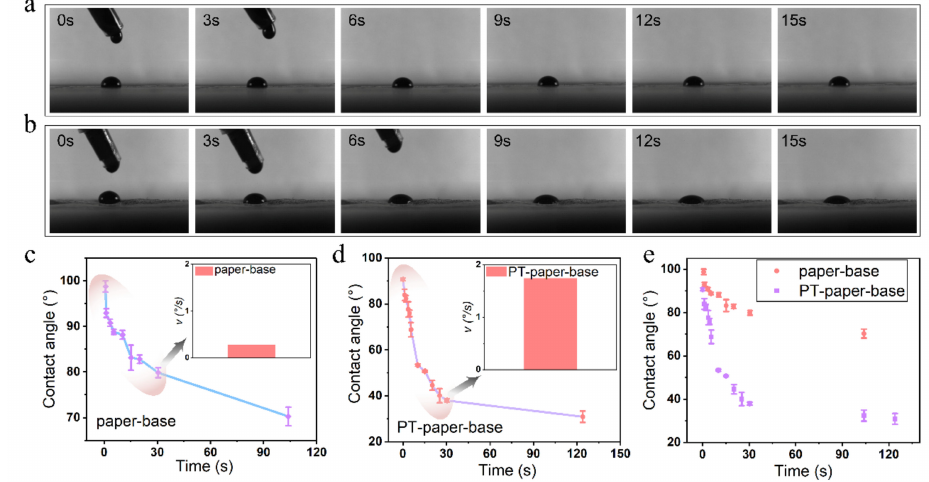
Figure 11. Infiltration of the tobacco extract on different tobacco paper-base surface. High-speed camera images of tobacco extract absorption on the ( a ) tobacco paper-base and ( b ) PT-tobacco paper-base surface; The infiltration contact angle of tobacco extract on the ( c ) tobacco paper- base and ( d ) PT-tobacco paper-base surface vs. time; ( e ) The infiltration contact angle compari- son of the tobacco extract on the tobacco paper-base and PT-tobacco paper-base surface. Inset: the mean infiltration rates of the tobacco extract on the ( c ) reconstituted tobacco paper-base and ( d ) PT-reconstituted tobacco paper-base